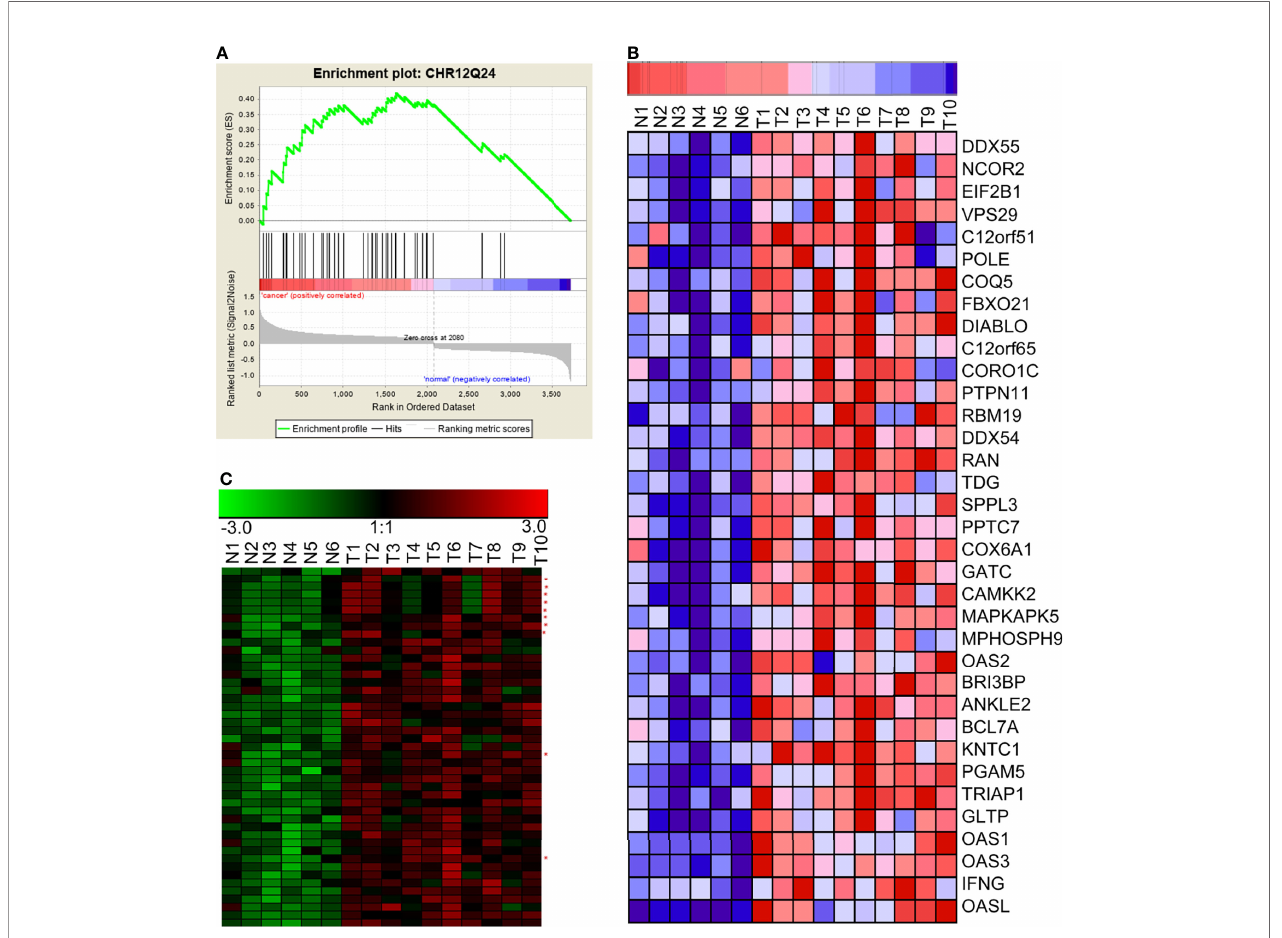
FIGURE 4 | GSEA revealed the concurrent up-regulation of a branch of lncRNAs and mRNAs located on the chromosome 12q24 region. (A) GSEA showed that genes in the chromosome 12q24 region were signi fi cantly enriched in NPC. (B) mRNAs in the chromosome 12q24 region were signi fi cantly up-regulated in NPC. (C) lncRNAs and mRNAs in the chromosome 12q24 region were concurrently up-regulated (red asterisks beside the right of the heatmap indicate lncRNAs; the rest of the rows represent mRNAs). N, the nasopharyngeal epithelium; T, nasopharyngeal